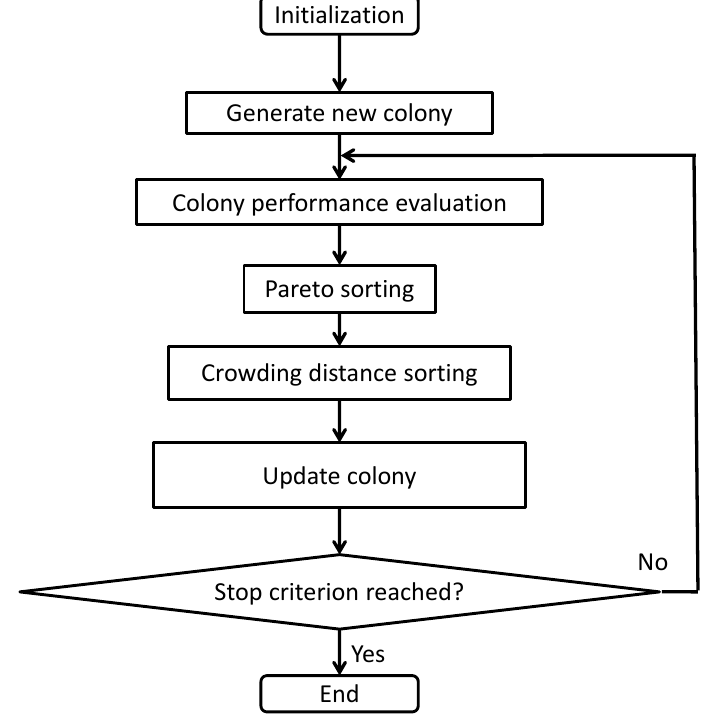
Figure 2. Flowchart of the multi-objective front-guided continuous ant-colony optimization (MO-FCACO).